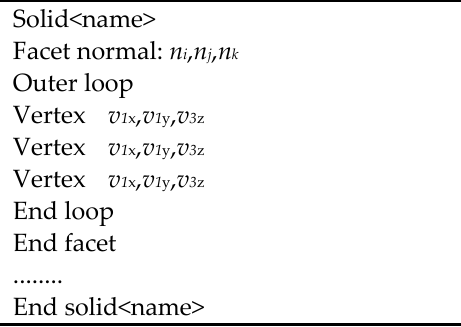
Figure 1. Parsing of a STL file in ASCII format.